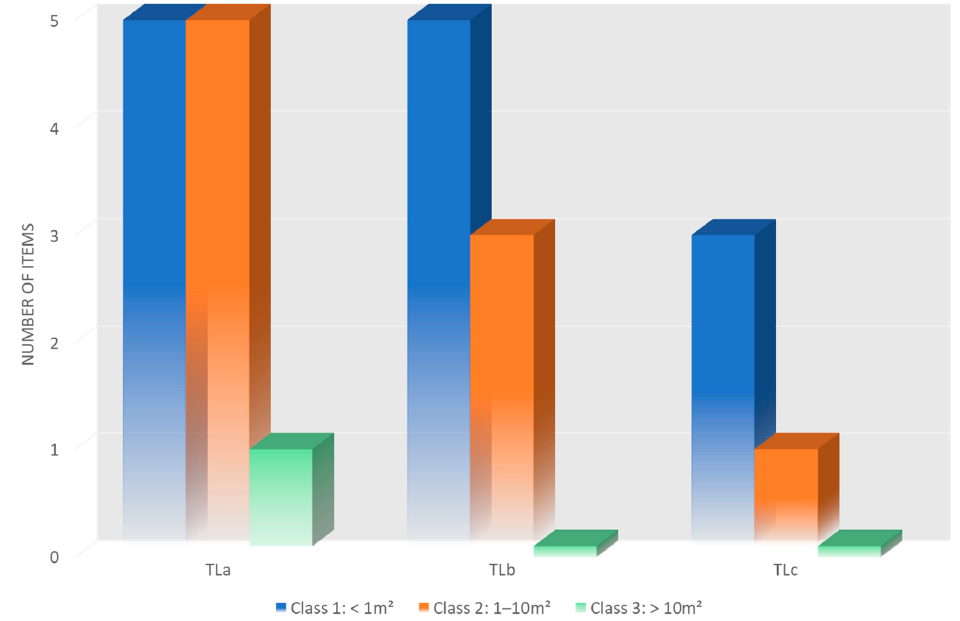
Figure 4. Di ff erence among the three transects in the seabed coverage of marine Figure 4. Difference among the three transects in the seabed coverage of marine litter.